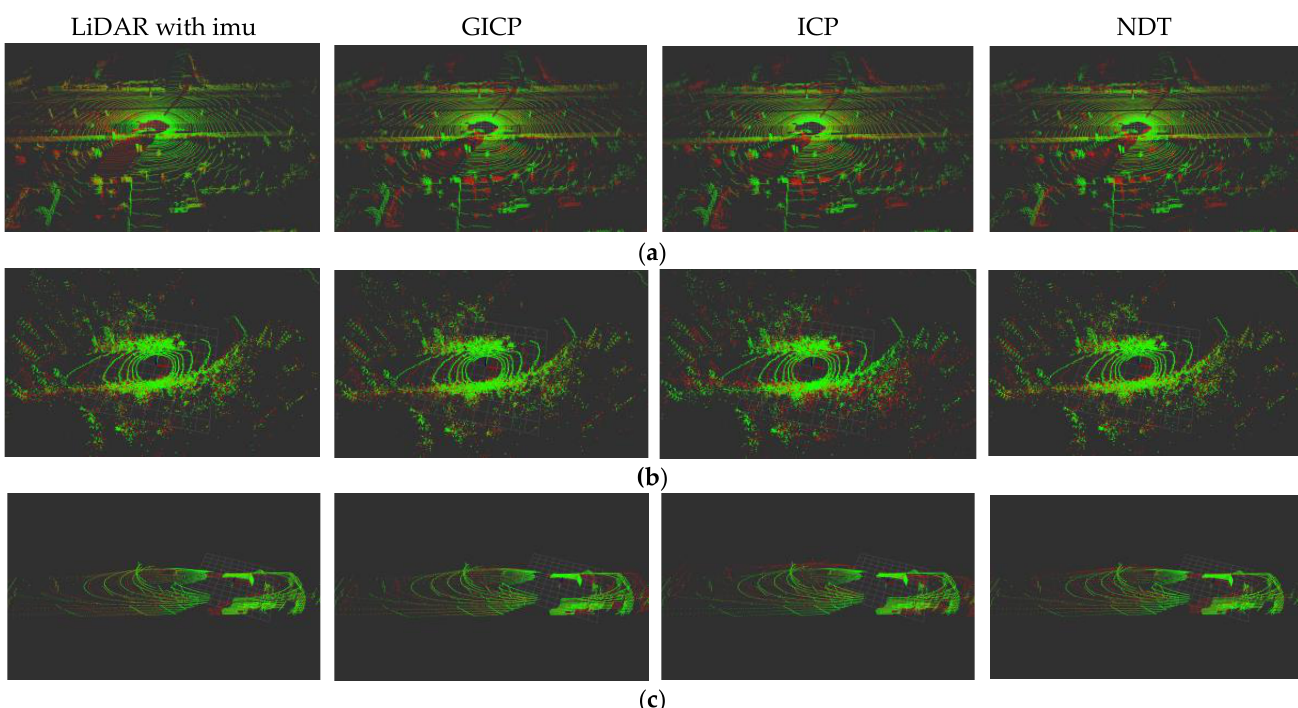
Figure 9. Display of point cloud registration results of different registration algorithms. ( a ) KITTI datasets; ( b ) Park datasets; ( c ) Coal mine roadway datasets.